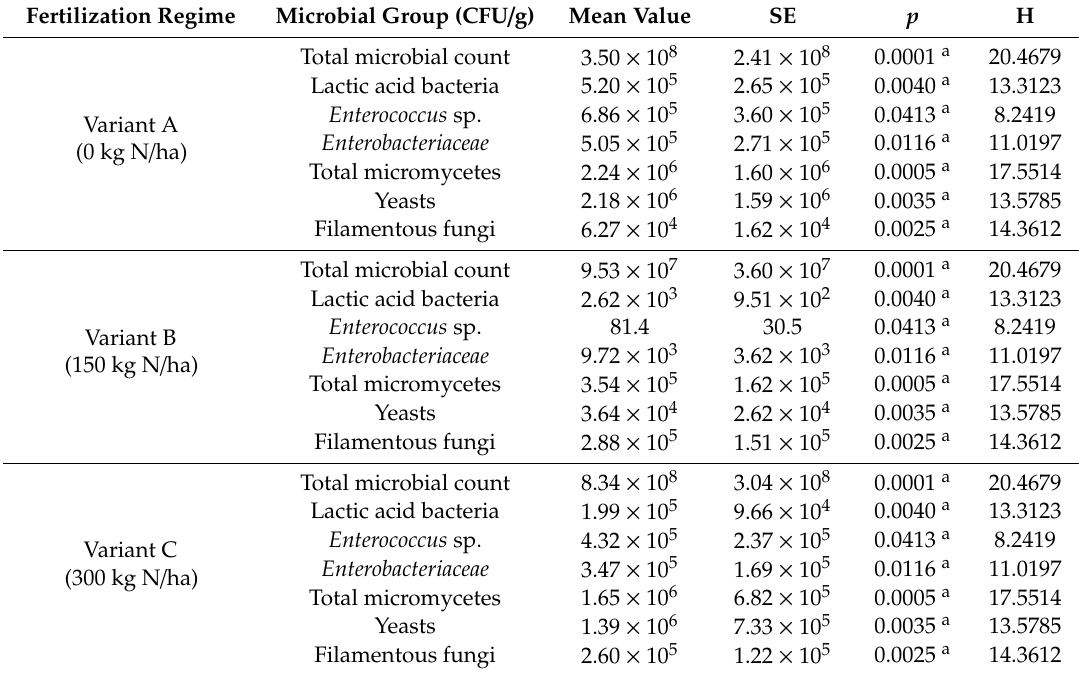
Table 3. Fertilization e ff ects on microbial counts in plant samples.